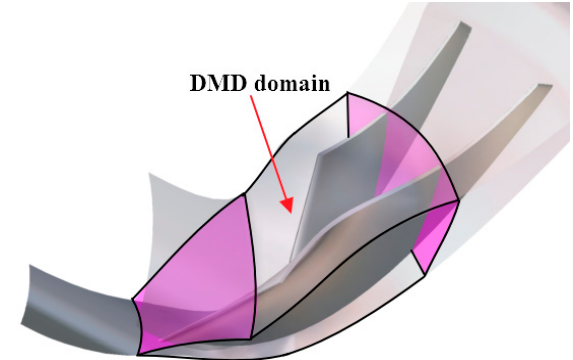
Figure 4. Dynamic mode decomposition (DMD) analysis domain.